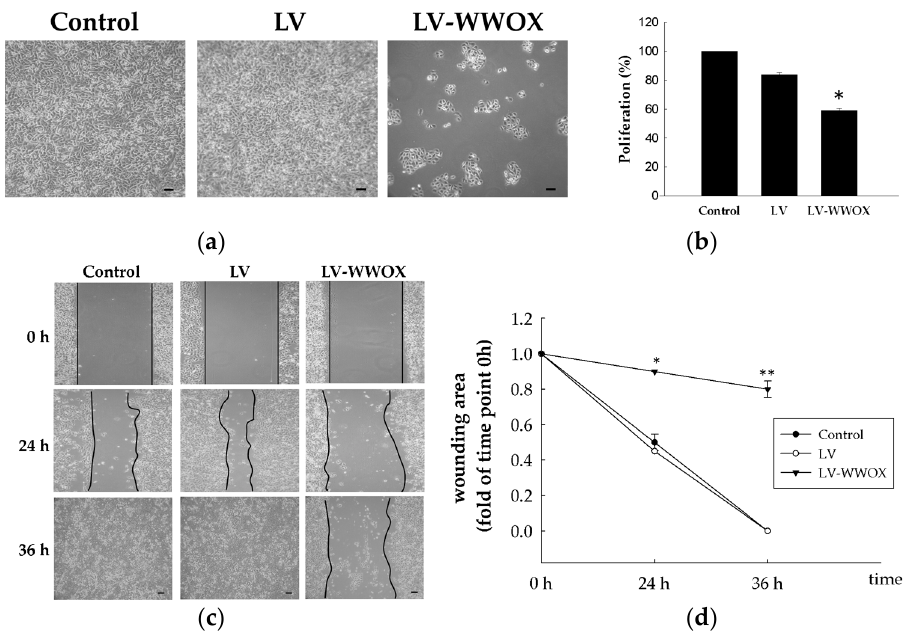
Figure 2. WWOX overexpression in the bladder cells inhibited cell proliferation in vitro. The ( a ) cell growth and ( b ) cell proliferation of the AY-27 cells were measured by MTS assay. ( c ) Wound-healing assay and ( d ) wound closure expressed as the remaining area uncovered by the cells. The scratch area at time point 0 h was set to 1 ( n = 3; * p < 0.05 and ** p < 0.01 vs. the respective control condition). The black bar in the right lower corner is 100 mm.